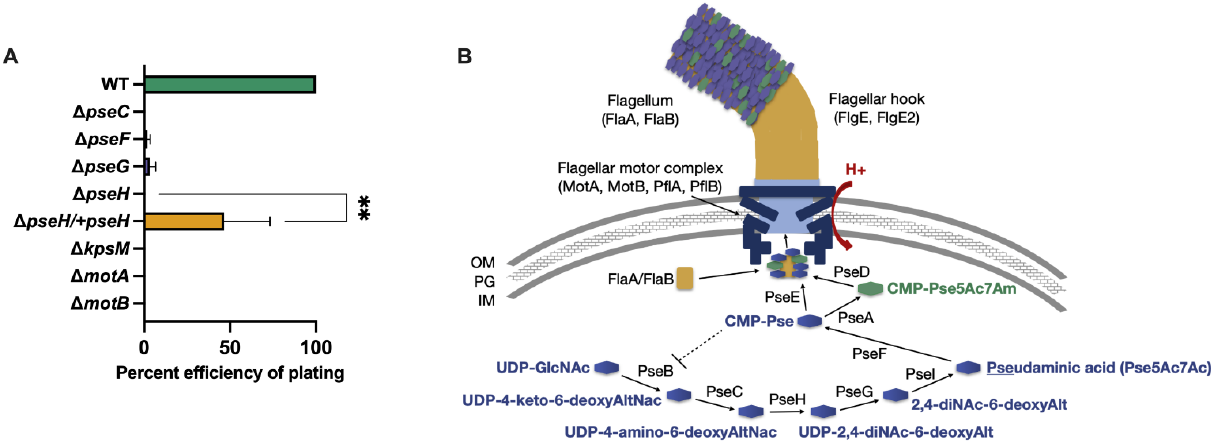
Figure 1. ( A ) Percent efficiency of plating (EOP) of phage NCTC 12673 on C. jejuni NCTC 11168 wild type (WT)